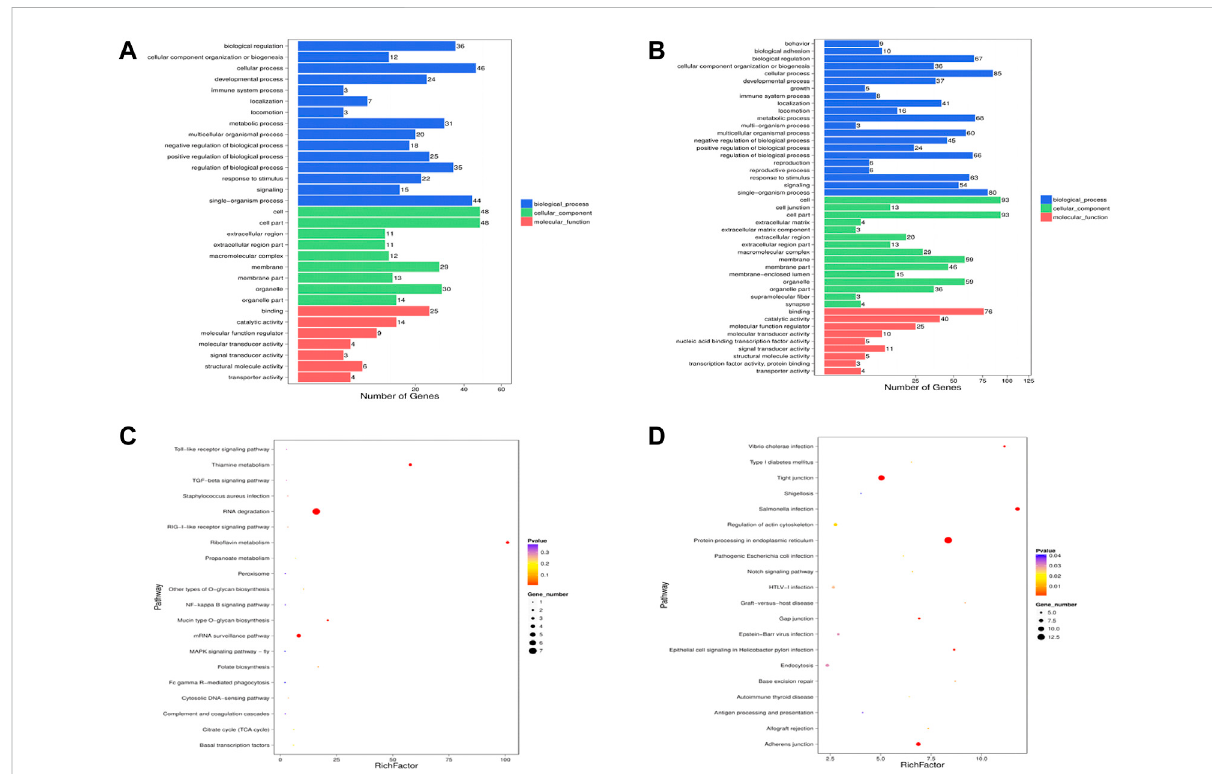
FIGURE 4 EnrichmentanalysisoftheDEmiRNAstargetgenes.GOanalysiswasperformedfortheknown (A) DEmiRNAstargetgenesandthenovel (B) DE miRNAstargetgenes,andthetermswithsigni fi cantenrichmentinBP,CCandMFcategorieswereimaged.KEGGanalysiswasper-formedforknown (C) DE miRNAs target genes and novel (D) DE miRNAs target genes, and only the top 20 signi fi cantly enriched pathways were